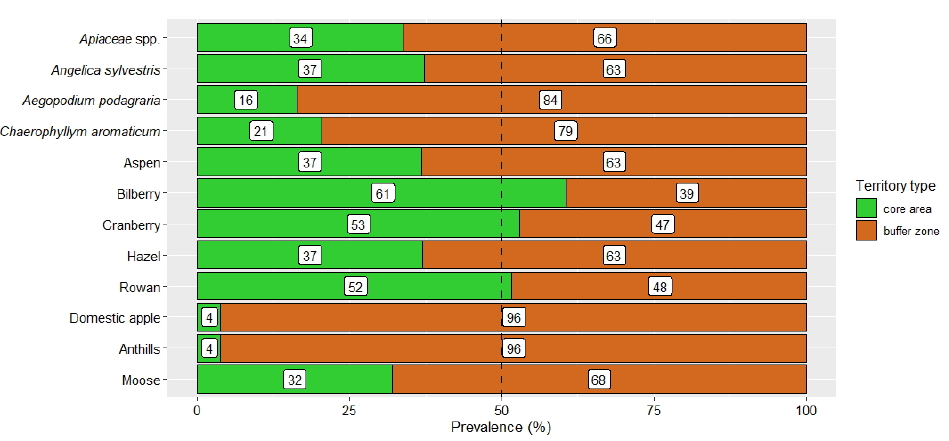
Figure 7. The global map of brown bear food resource richness in the Central Forest State Nature Reserve (West-European Russia) in 2008–2020. The colours indicate the number of food resources (one to seven) per pixel among the following items: Apiaceae spp., aspen, bilberry, cranberry, hazel, rowan, domestic apple, anthills, and moose. The CFNR core area is inside the red line polygon; the CFNR buffer zone is outside the red line polygon. For the map with combination of individual food resources, see Figure A6.